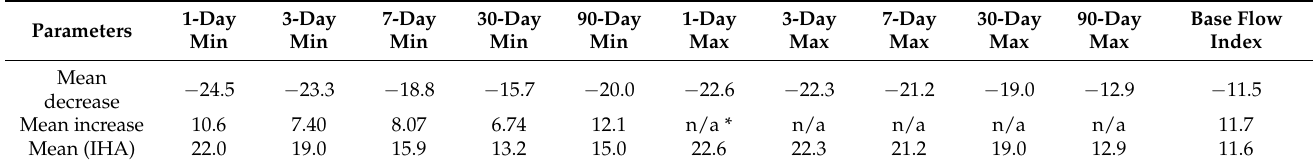
Table 5. Change (%) in the magnitude and duration of annual extreme flows (group 2 of IHA parameters).